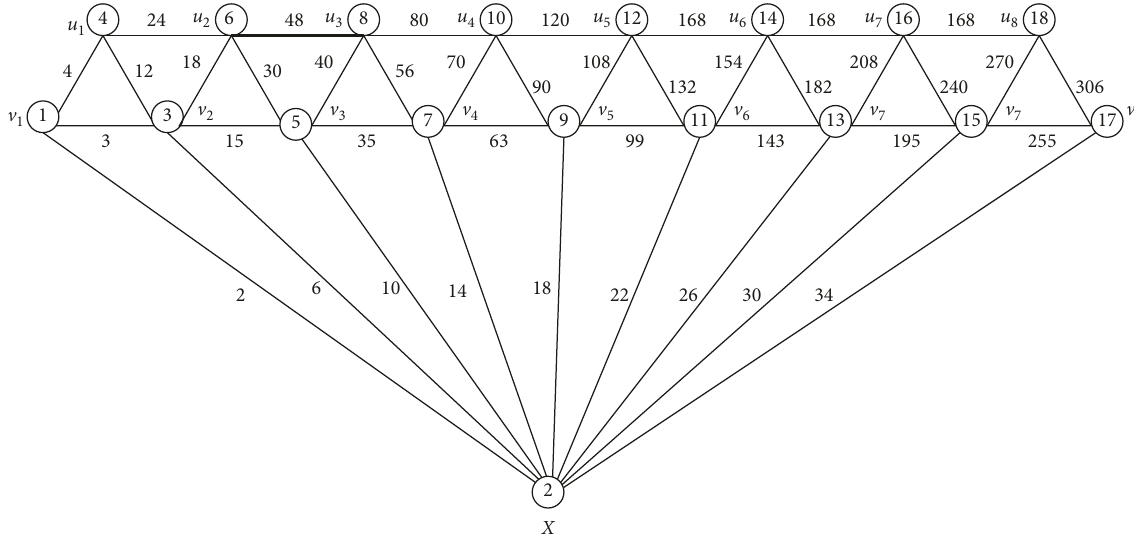
Figure 1: Representation of Br